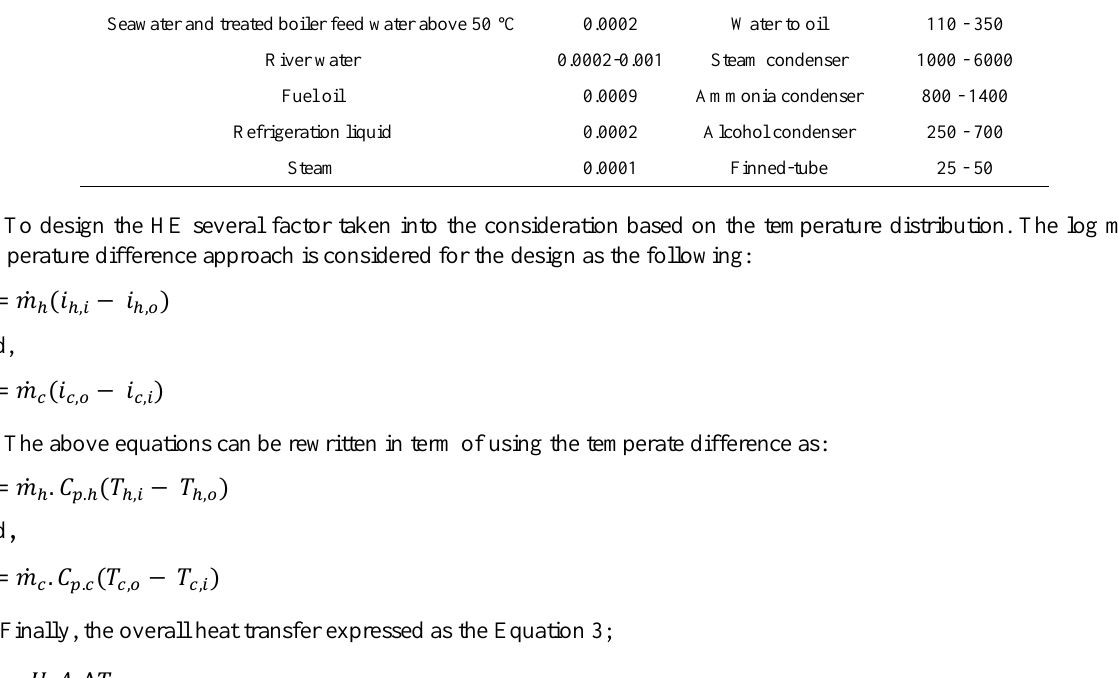
Table 1. Overall heat transfer coefficient and fouling factors for selected systems Fluid R f (m 2 .K/w) Fluid combination U (W/m 2 .K) Seawater and treated boiler feed water below 50